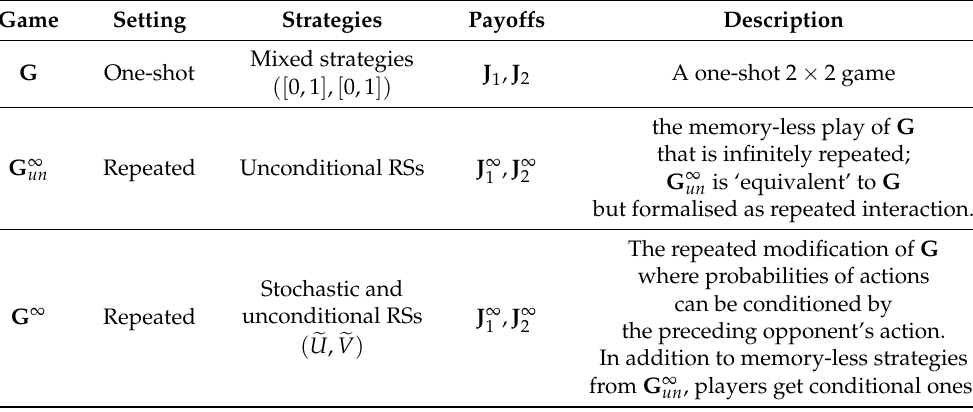
Table 1. Summary for two-player games considered in the